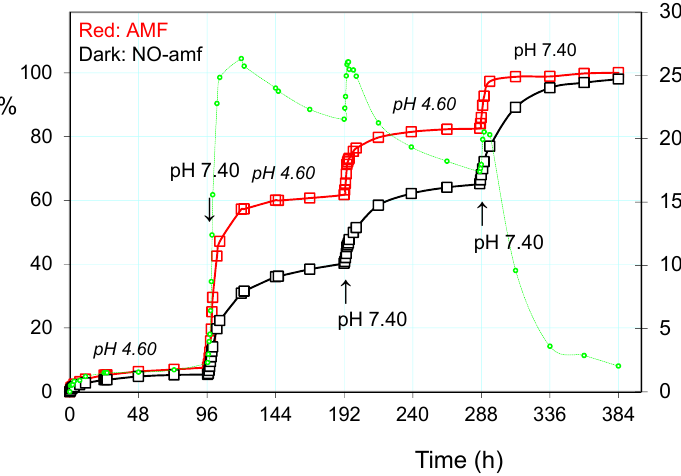
Figure 4. Paroxetine release (%) from the hydrogel PHE-Nip3 on pulsed variation of buffer solutions (PBS, pH 7.40; acetate, pH 4.60) with (red line) and without (dark line) AMF application (20 kHz/50 W). The green dashed line represents the difference (%) between the release values with and without the application of AMF.